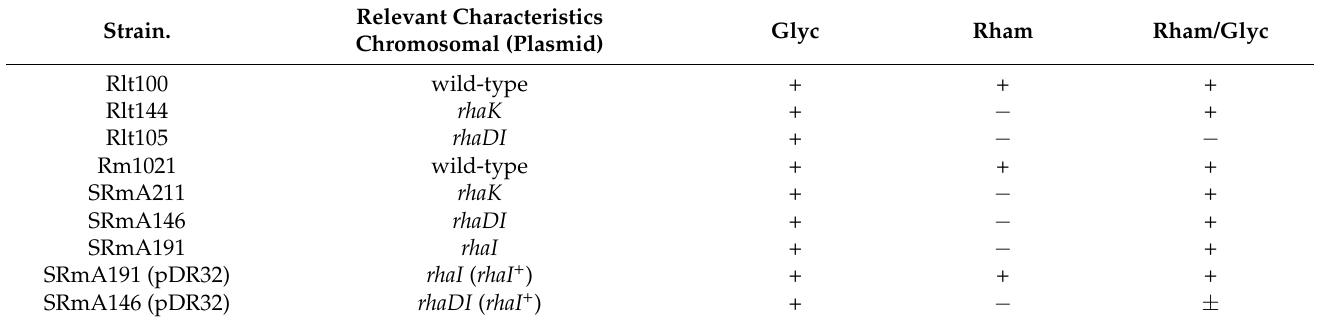
Table 2. S. meliloti displays different conditional growth phenotypes than R. leguminosarum .